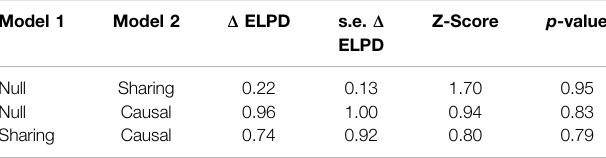
TABLE 1 | The results of causality of HCV infection and AD by comparing causal and sharing model. Model